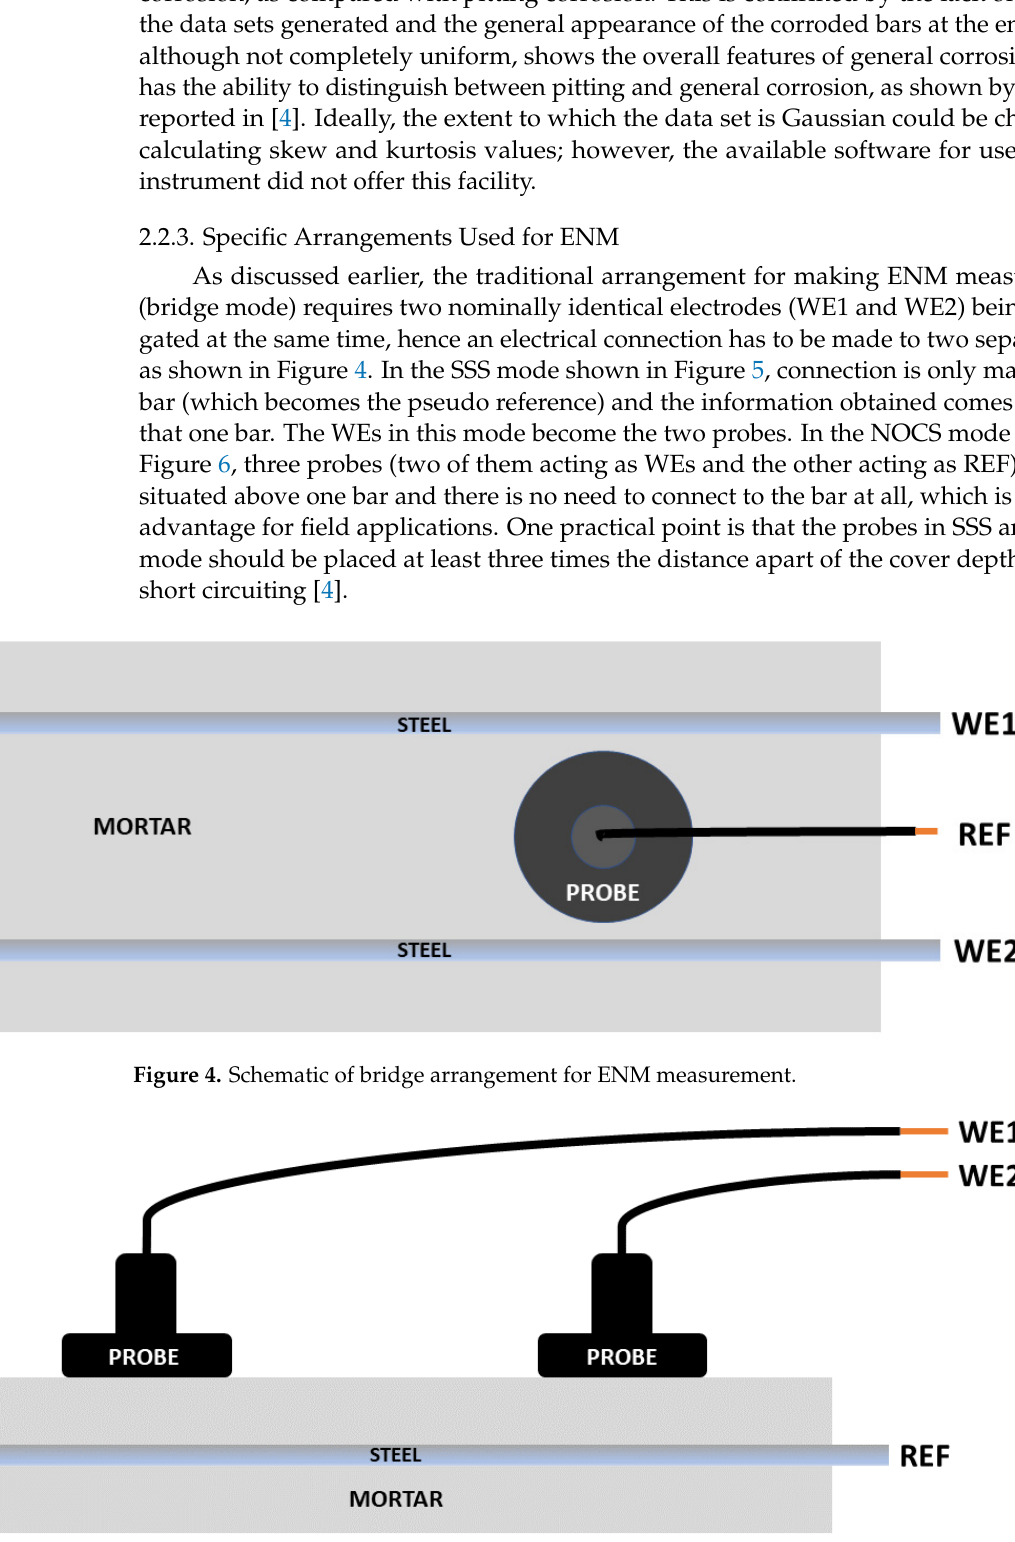
Figure 5. Schematic of simple single substrate (SSS) arrangement for ENM measurement.